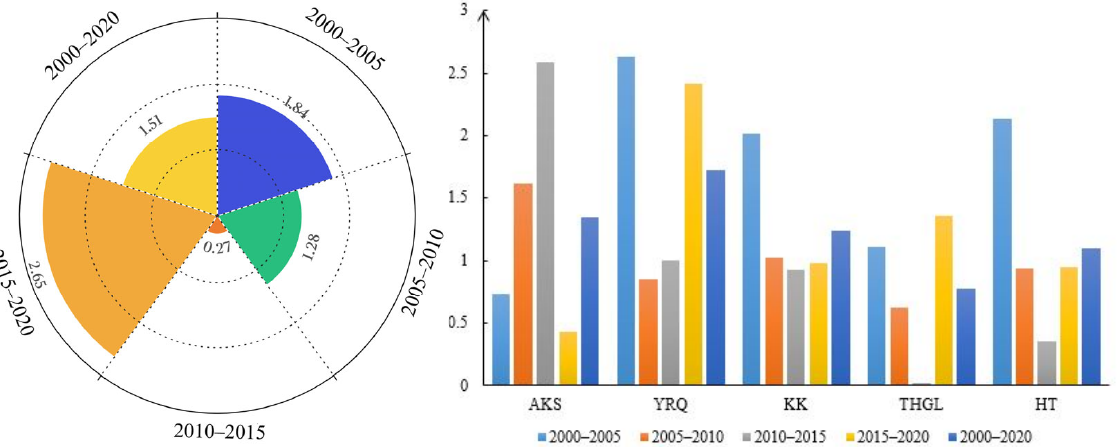
Figure 4. Average elasticity of ESV to LUCC in the TRB (the left figure is the average elasticity of the TRB, and the right figure is the average elasticity of each sub ‐ basin).